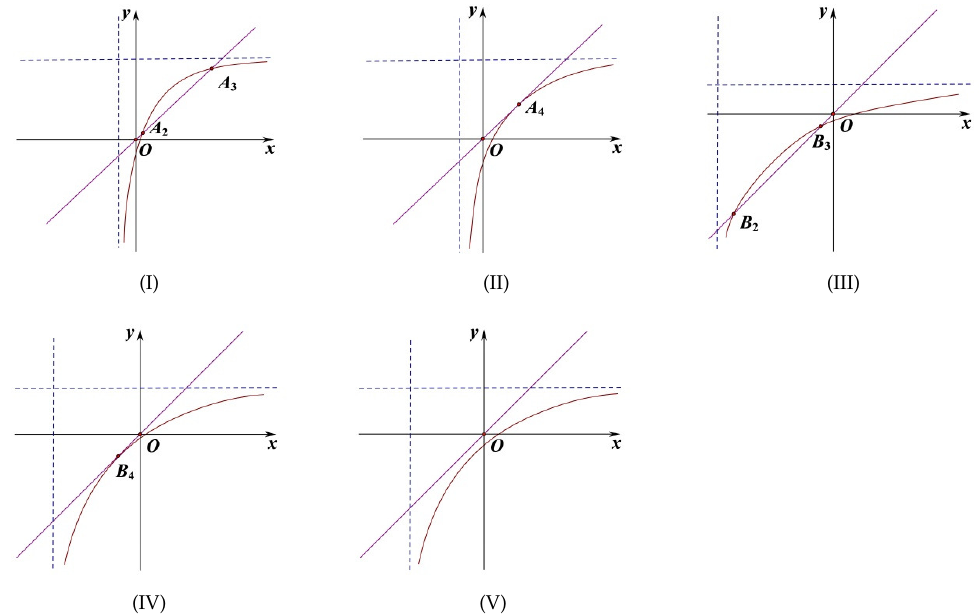
Figure 3. Figure ( I – V ) show the locations of the equilibria under the case br − c < 0. x denotes the density of the population and y indicates the impact of distributed time delay. Figure ( I ) shows the locations of the equilibra in the case br − c < 0, r − ω b > 0 and q 2 > 0; The conditions for Figure ( II ) are br − c < 0, r − ω b > 0 and q 2 = 0; br − c < 0, r − ω b < 0 and q 2 > 0 correspond to Figure ( II ); br − c < 0, r − ω b < 0 and q 2 = 0 are the conditions of Figure ( IV ); Figure ( V ) represents the equilibrium of the system under the case br − c < 0 and r − ω b =